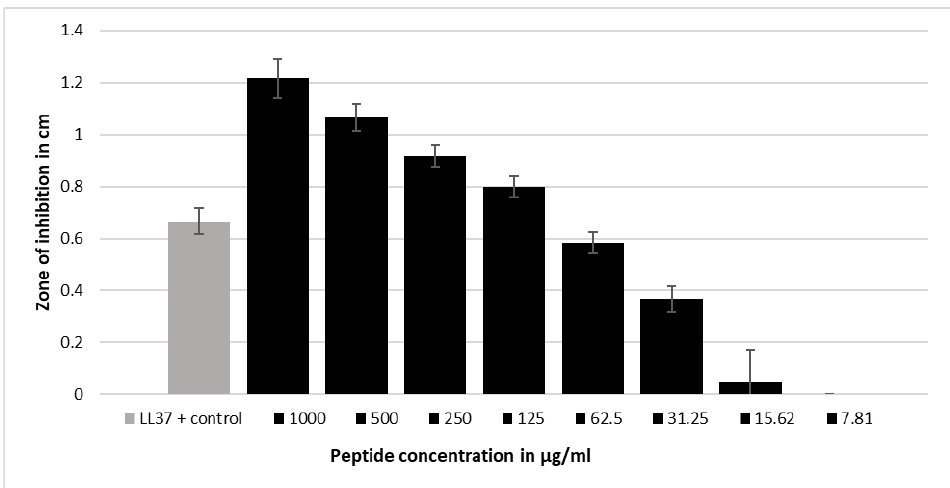
Figure 6. A radial diffusion assay indicated that the peptide Urine-3462 is active against the Pseudomonas aeruginosa strain ATCC 27853. Inhibition zones are quantified in cm. The mean values and standard deviations of six independent experiments are shown. LL37 at 100 µg/mL was used as positive control (see Table S3 for exact values).